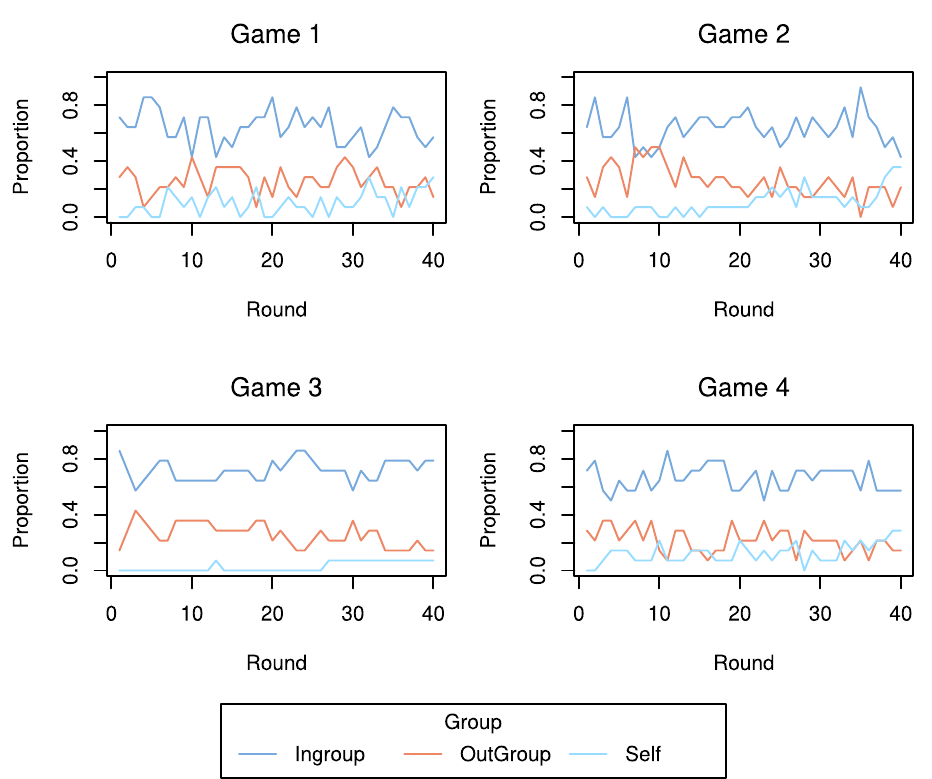
Figure 4. Proportion of tokens received from the ingroup, outgroup and self at each